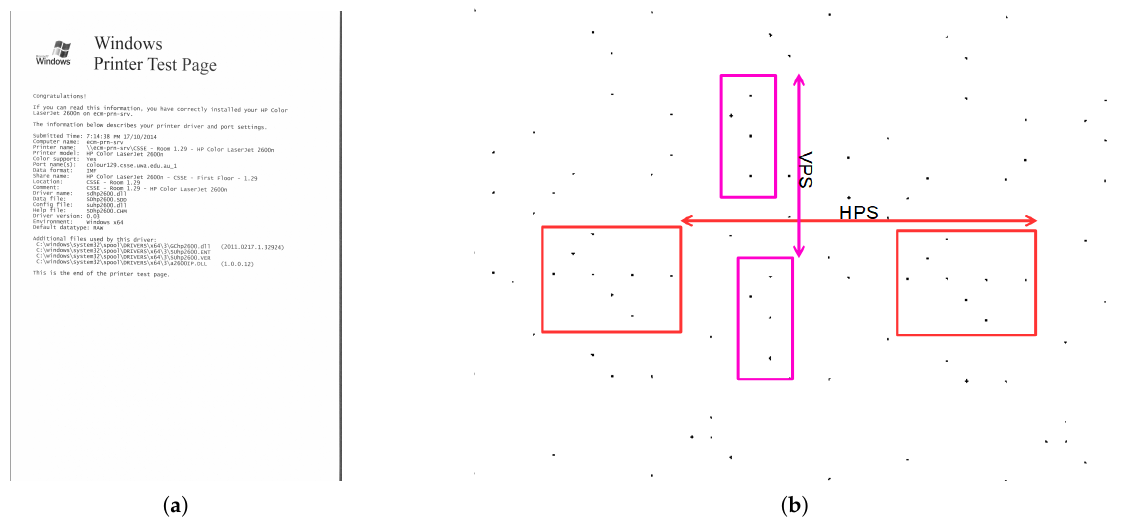
Figure 11. Extraction of counterfeit protection pattern by image processing: ( a ) Royal Blue band of a test printed document (zoom to 6400% to clearly view the pattern); and ( b ) processed image of enhanced codes separated by horizontal pattern separation (HPS) and vertical pattern separation